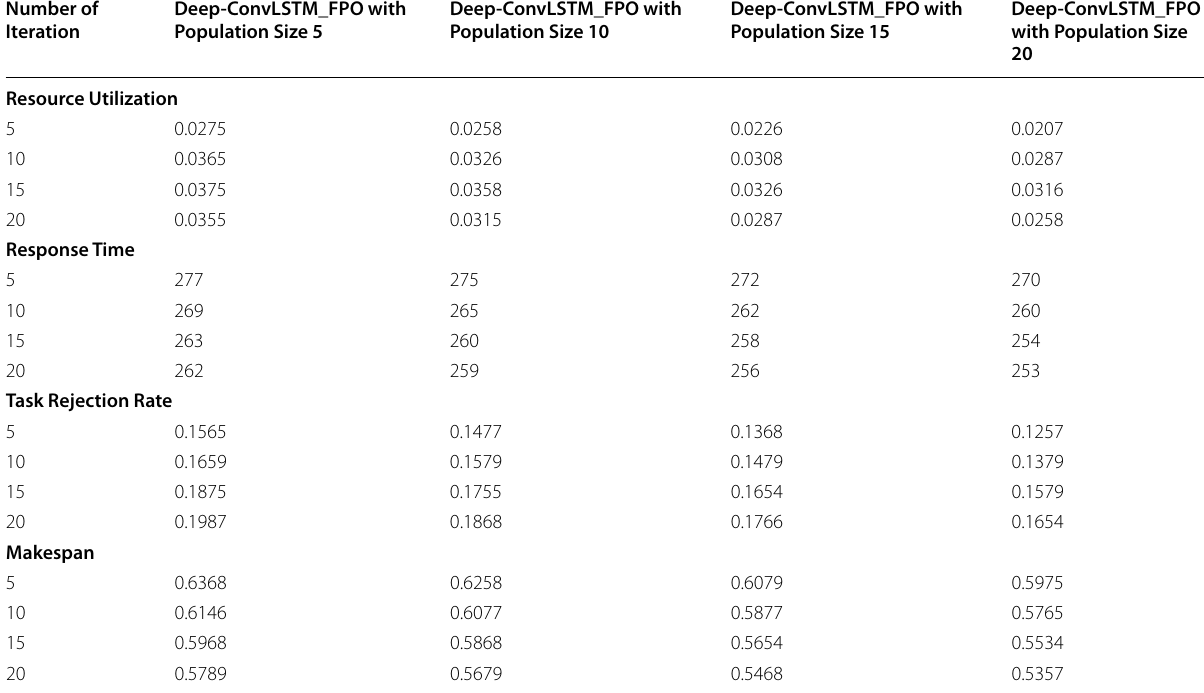
Table 2 Performance Assessment of Deep-ConvLSTM_FPO with Task Size 100 Number of